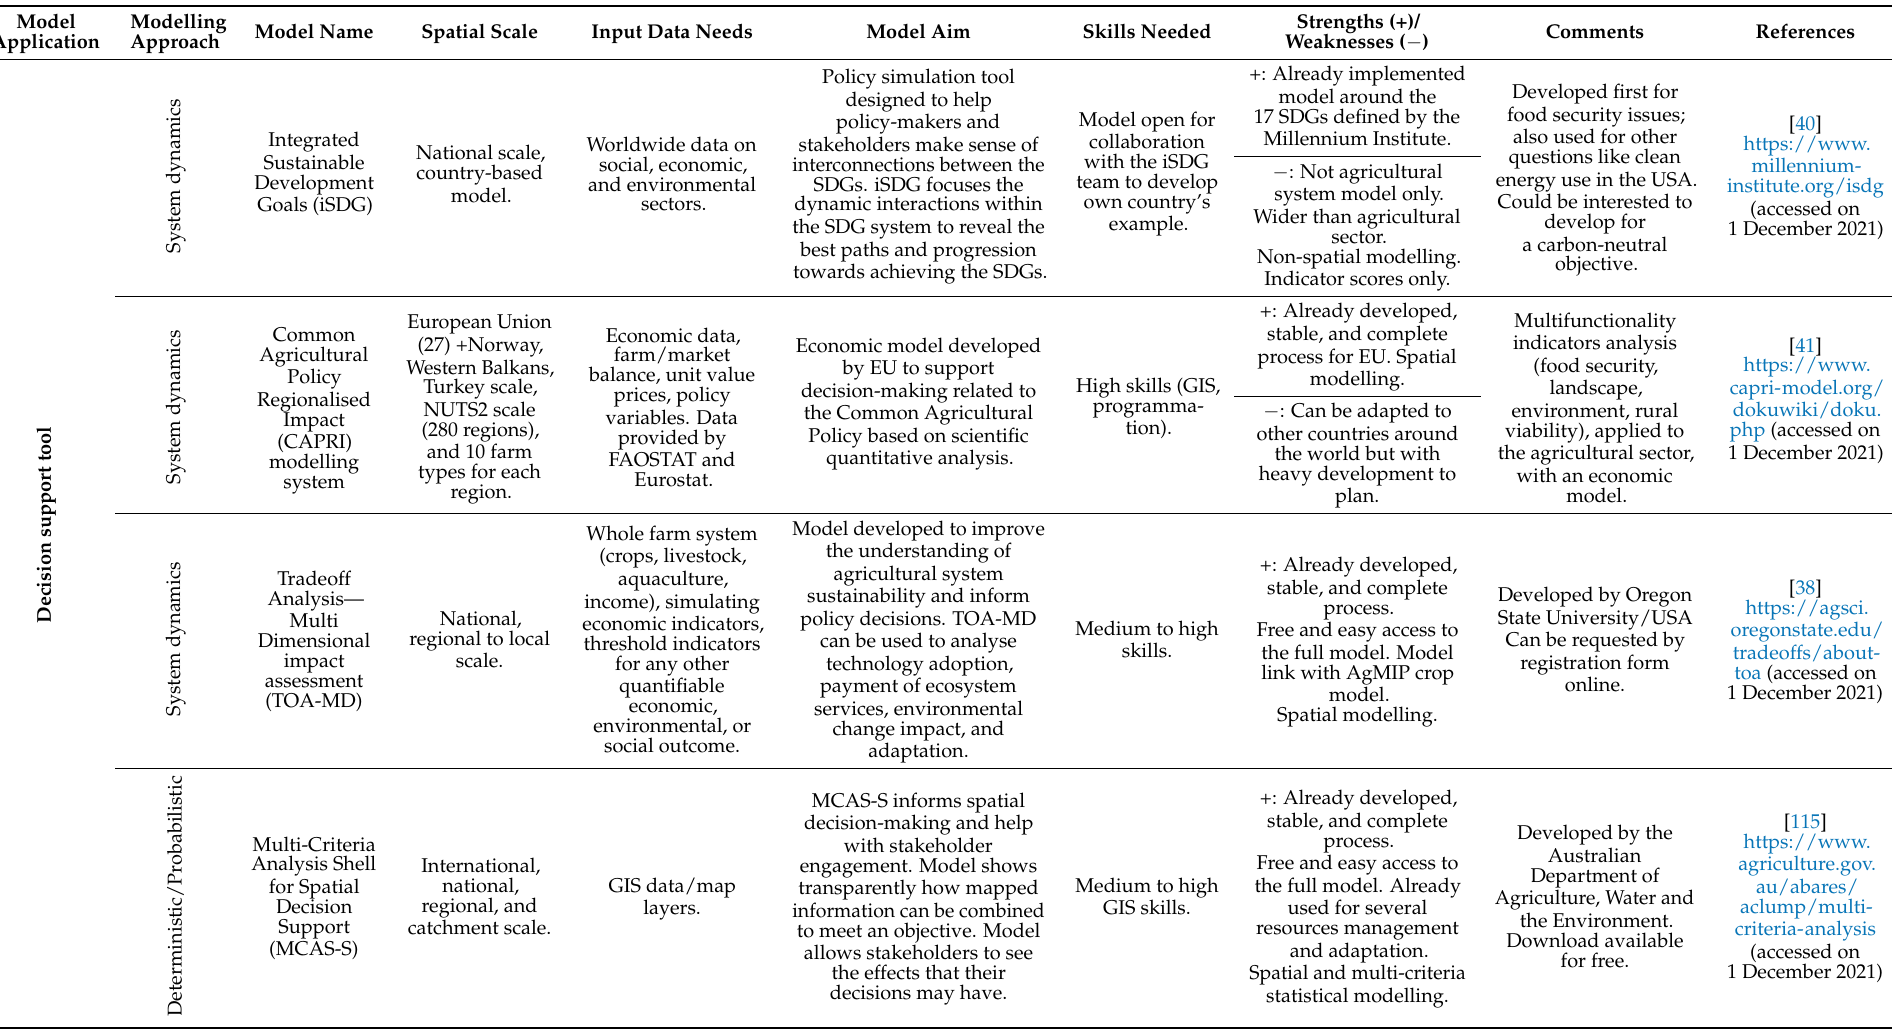
Table 1. Examples and thematic applications of national and regional agro-environmental